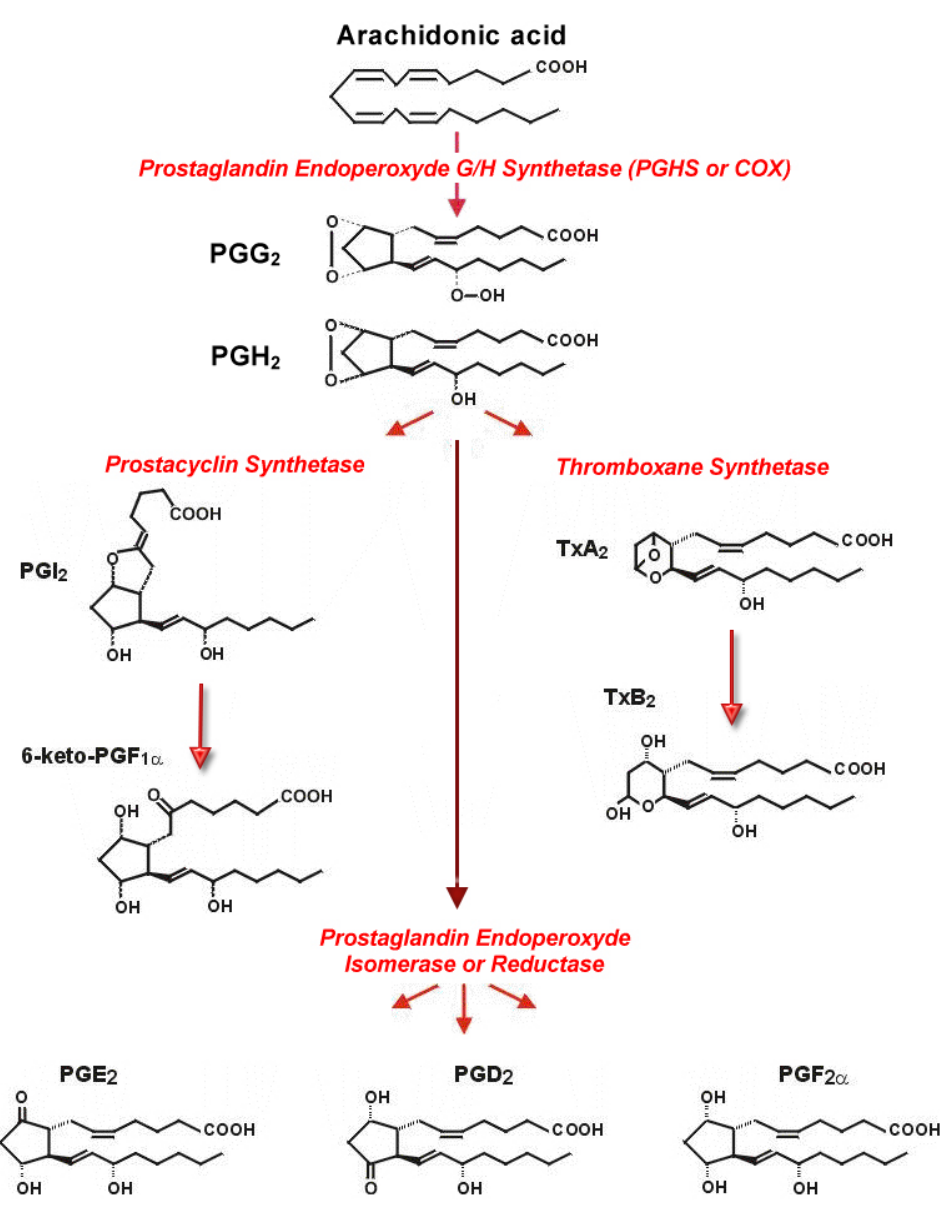
FIGURE 1 . Principal prostanoids derived from arachidonic